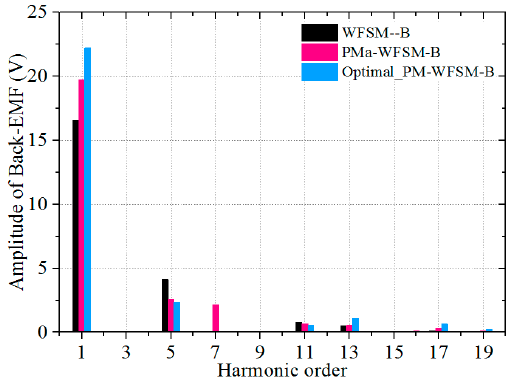
Figure 16. Harmonic analysis of back-EMFs.